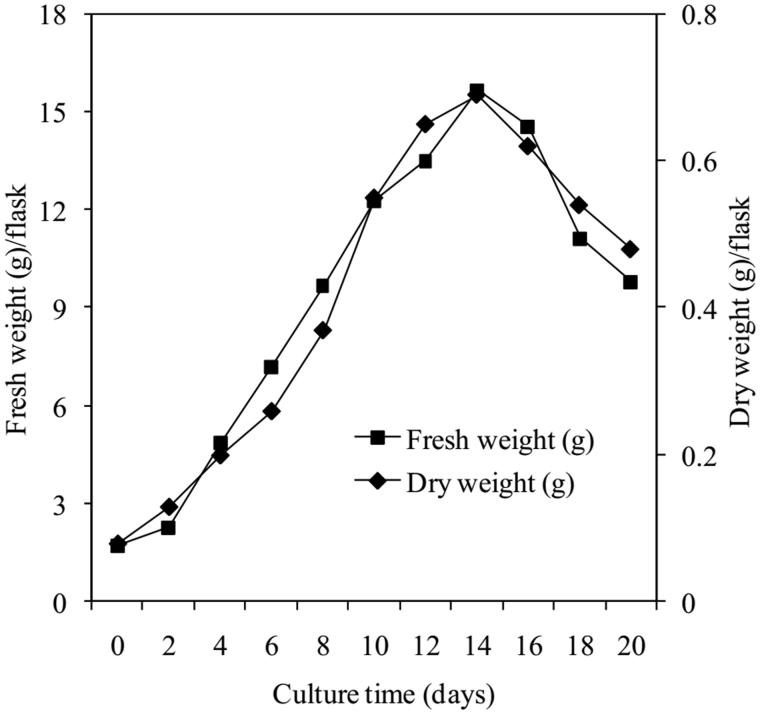
Time course of E. longifolia cell growth.